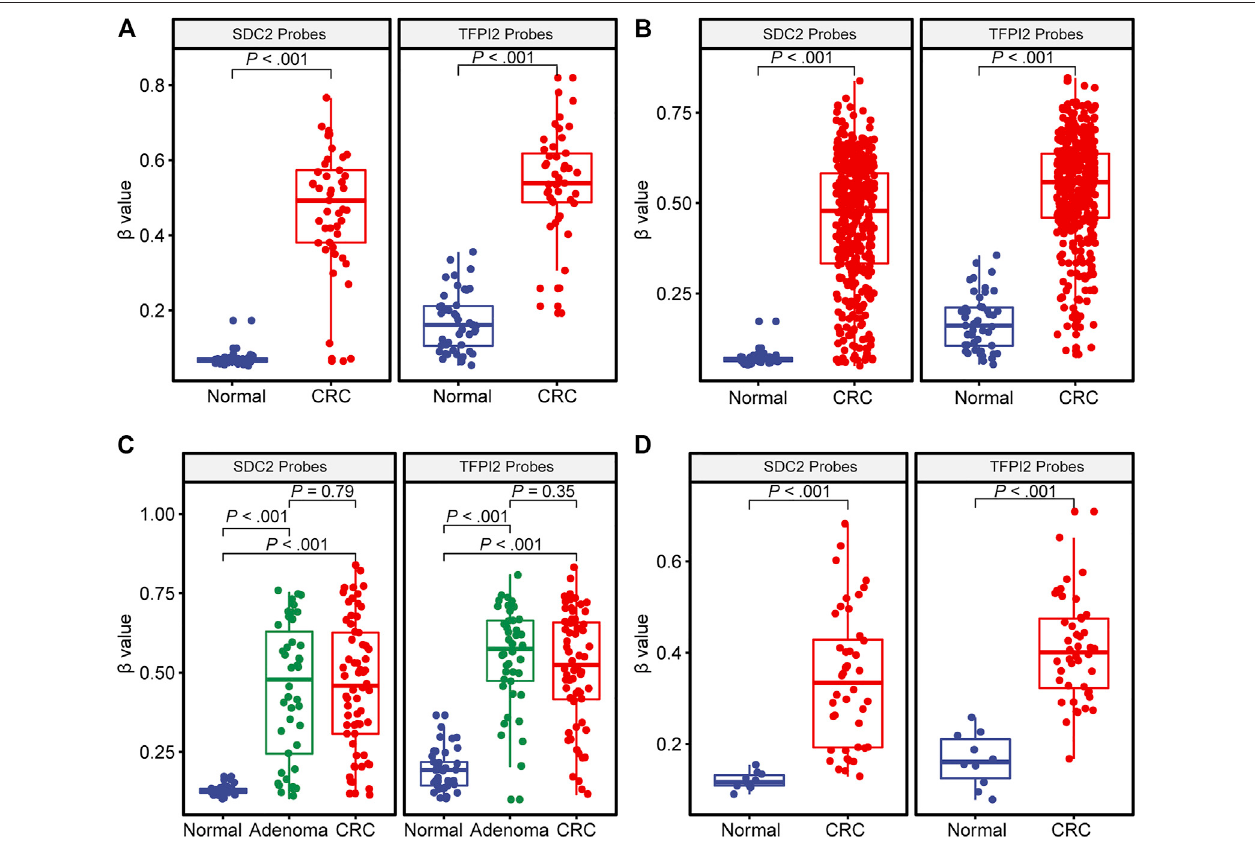
FIGURE 1 | DNA methylation level ( β value) of SDC2 and TFPI2 in CRC, adenoma, and normal tissues. The abscissa is the type of tissue, and the ordinate is the methylation level ( β value). Each dot indicates an individual specimen. The extremes of the boxes de fi ne the upper and lower quartiles, and the center lines de fi ne the median.Whiskersindicate1.5 × interquartilerange(IQR).BeyondIQRarede fi nedtheoutliers. (A) illustratesthedistributionofmethylationlevelsin45CRCspecimensvs. theirpaired normal tissue specimens from TCGA. (B) shows 391CRC vs. 45normaltissuespecimens fromTCGA. (C) isbased on thedataset ofGSE48684, with 106CRC,42adenoma,and41normaltissuespecimens. (D) isbasedonGSE79740,with44CRCand10normaltissuespecimens.TheWilcoxonsigned-ranktestwas used for (A) and Mann – Whitney U test for (B – D)